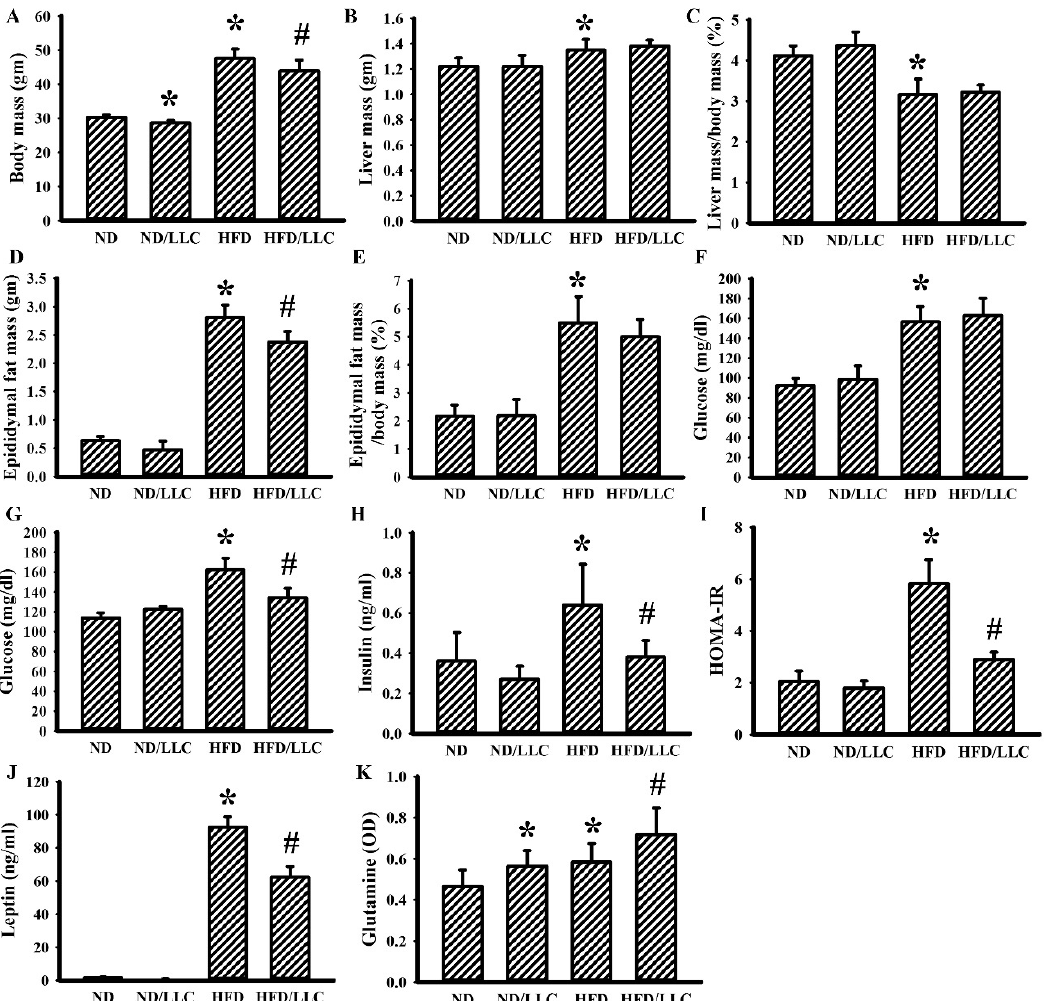
Figure 1. Tumor growth improved glucose metabolism in obese mice. LLC cells (LLC) or saline vehicle were implanted into the lean (normal diet, ND) and obese (high fat diet, HFD) mice, and grew for 2 weeks. The body mass ( A ), liver mass ( B ), relative percentage of liver mass ( C ), epididymal fat mass ( D ), and relative percentage of epididymal fat mass ( E ) were weighed and analyzed. Fasting glucose levels were measured at times of pre-implanted ( F ) and post-implanted ( G ). Fasting insulin level ( H ), Homeostasis Model Assessment-Insulin Resistance (HOMA-IR) ( I ), leptin level ( J ), and glutamine level ( K ) were determined. * p < 0.05 vs. ND and # p < 0.05 vs. HFD (n = 5 per group).